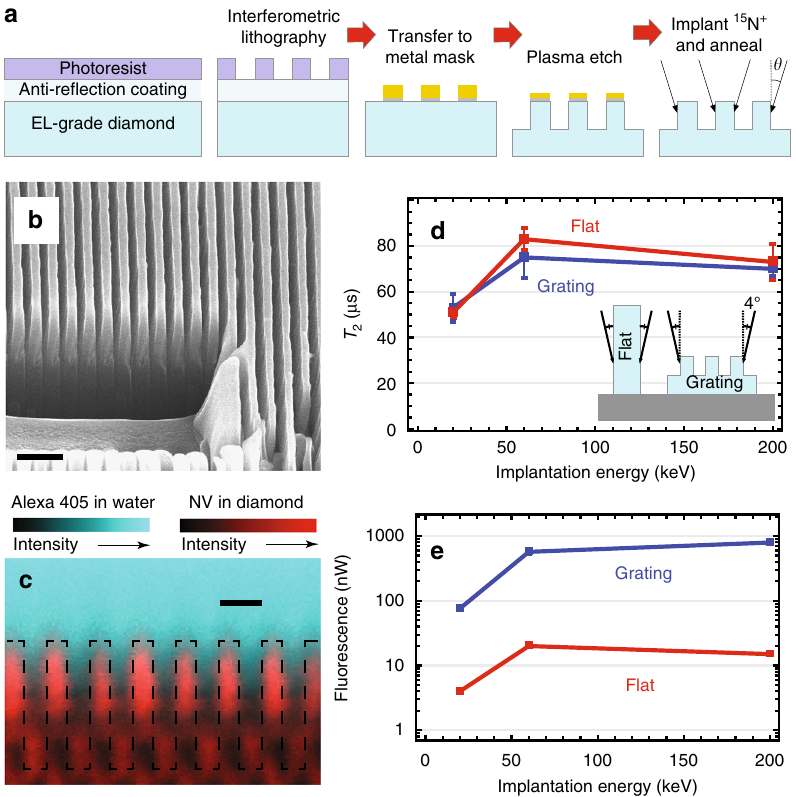
Fig. 2 Diamond nanogratings. a Schematic of large-area nanofabrication process. b Scanning electron micrograph of 400 nm pitch diamond nanogratings. Focused ion beam etching prior to imaging enabled visualization of the nanogratings ’ cross-section. Scale bar is 1 μ m. c Confocal microscopy images reveal that fl uorescence from dye-stained water originates from areas inside the nanograting grooves, con fi rming wetting. Dashed lines represent the estimated diamond – water boundary. Scale bar is 500 nm. d Comparison of T 2 , measured with the XY8-22 protocol, and e fl uorescence intensity between fl at and nanograting chips implanted at similar conditions. T 2 can surpass ~100 μ s with suf fi cient decoupling π -pulses (see Supplementary Note 2). Error bars in d represent standard error of the